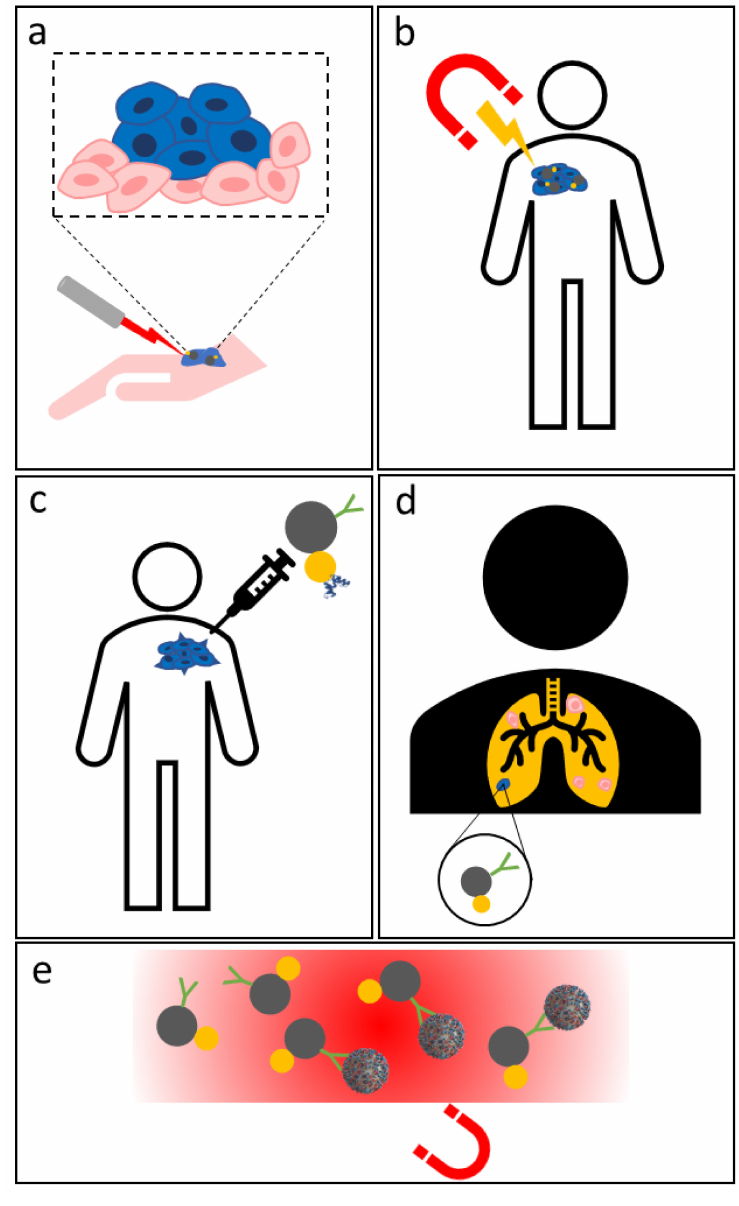
Figure 2. Schematization of photothermal therapy application ( a ), magnetic hyperthermia ( b ), drug delivery and targeting ( c ), bioimaging ( d ) and SERS application, detection and separation ( e